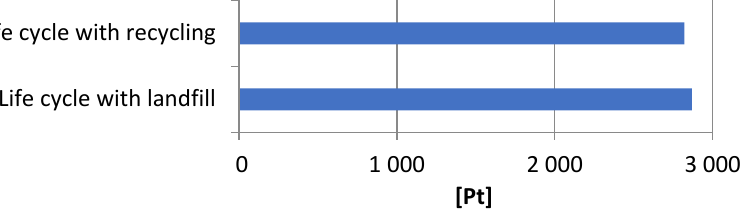
Figure 7. The results of grouping and weighing the environmental consequences occurring in the life cycle of the research object by the form of post-use management.